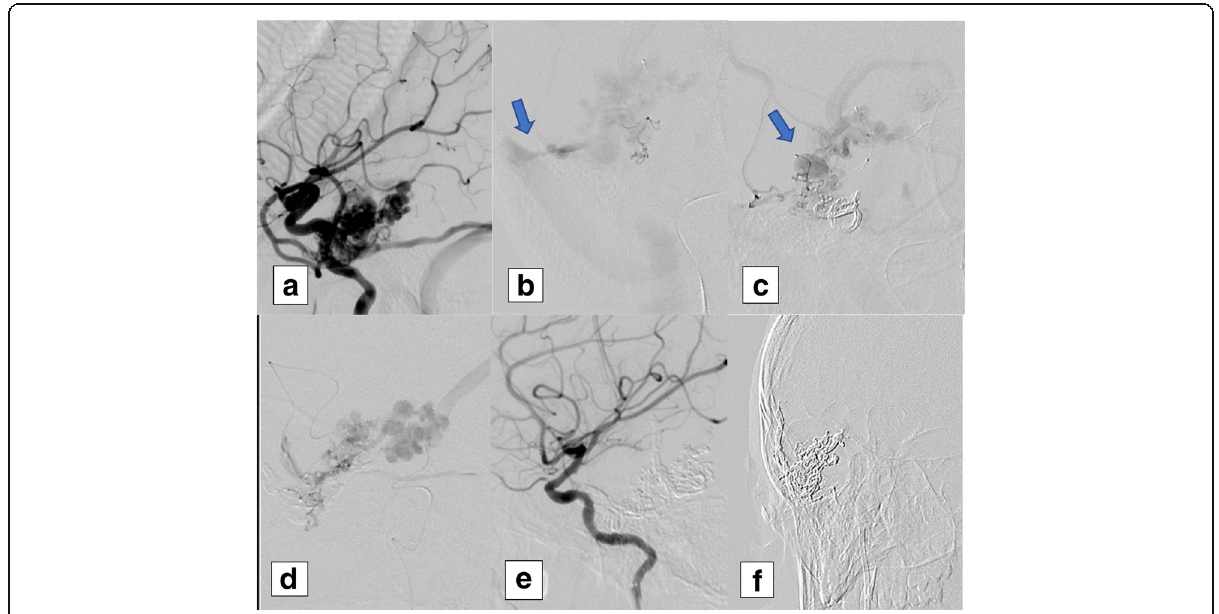
Fig. 2 A pediatric case with unruptured right temporal brain AVM. a Lateral view of a right internal carotid angiogram shows multiple feeders from the middle cerebral artery and superficial and deep venous drainage. b shows the 1st feeder angiogram with venous stenosis (arrow), c shows the 2nd feeder angiogram with venous aneurysm (arrow), and d shows the 3rd feeder angiogram. e Final result (complete occlusion) after embolization of 3 feeders. f shows Onyx cast after complete occlusion of the AVM